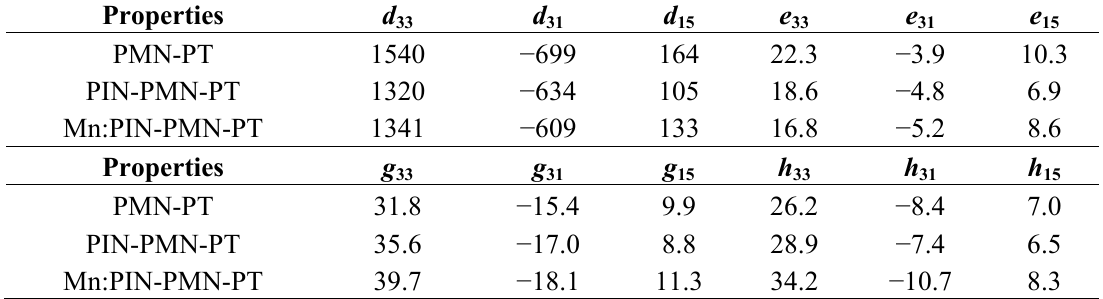
(pC/N), e (C/m 2 ), g (10 −3 Vm/N) and h ij ij ij